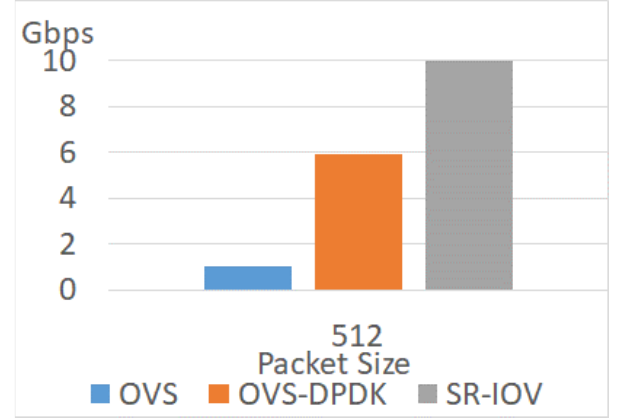
Figure 12. Throughputs of different technologies in PVP scenario when packet size is 512.